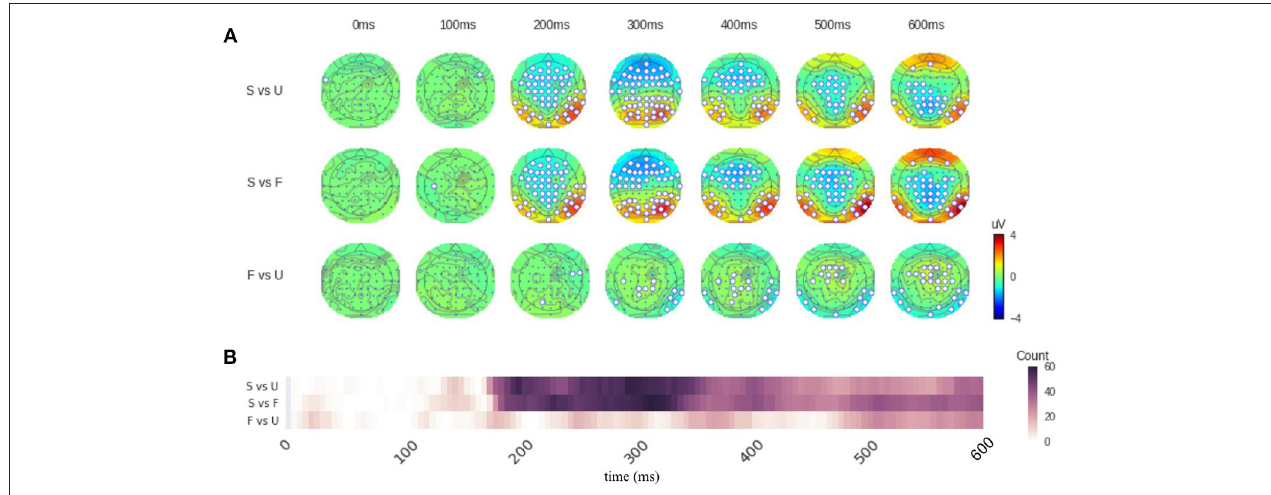
FIGURE 1 | Results of distribution of significant sensors analysis. (A) Topographies of response differences between conditions across time. Each row contains topographies for a given comparison at different time points. Sensors that show significant response magnitude differences are circled in white. The color on the topography represents the response magnitude differences. The conditions in each comparison is listed on the left. S for scrambled condition, F for famous face condition, and U for unfamiliar face condition. (B) The number of significant sensors across time. The color scale represents the number of significant sensors. The conditions of comparison are listed at the left side of the figure. Labels are the same as in (A) . The comparison between face perception conditions (F and U) and scrambled (S) condition is significantly different in sensors above frontal, central, bilateral parietal-occipital areas, starting around 180ms. The comparison between face perception conditions (F vs. U), however, only shows significant difference at the latencies of 300–400ms and 500–600ms. Refer to main text for detailed